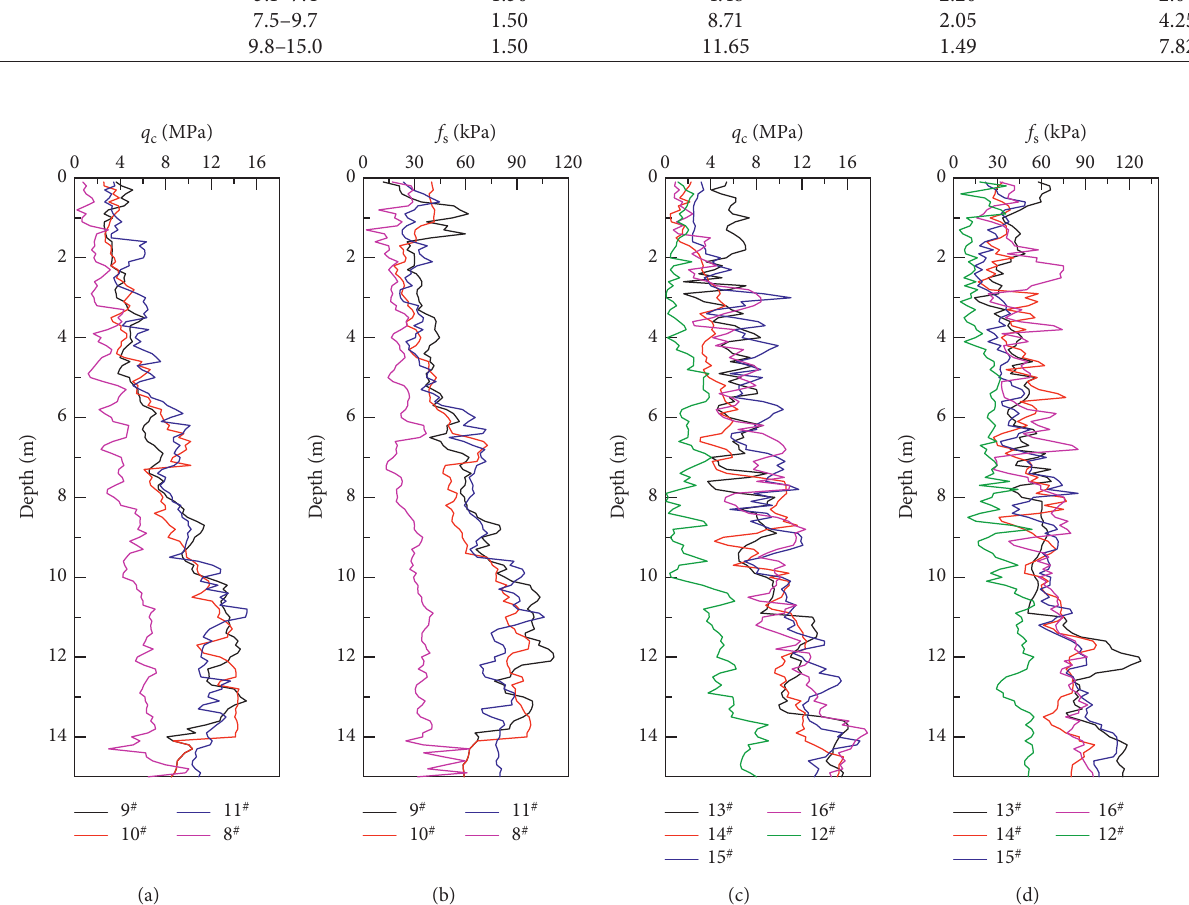
Figure 10: CPT results before and after foundation treatment with